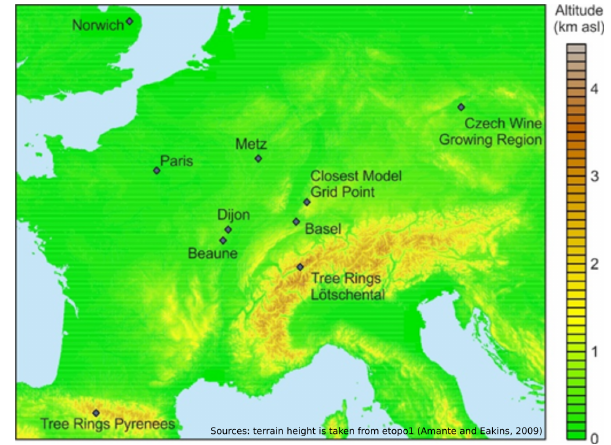
Figure 1. Geographical area of the study (taken from Amante and Eakins,